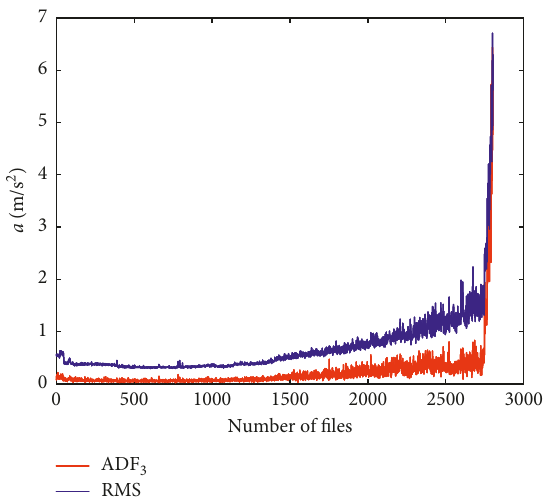
Figure 14: The ADF3 of (a) Case I and (b) Case II compared with